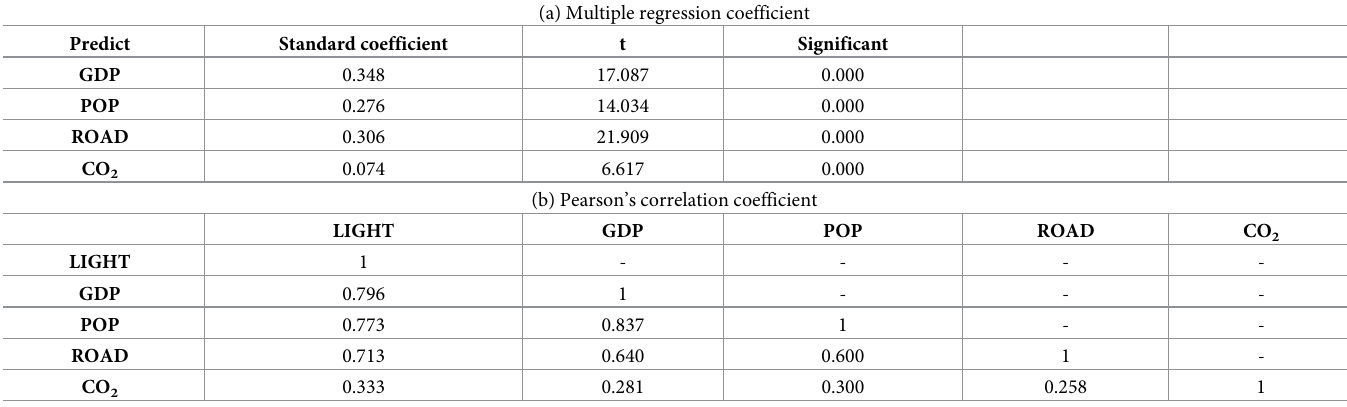
Table 10. Multiple regression coefficient and Pearson’s correlation coefficient of total NTL quantity at county level in China. (a) Multiple regression